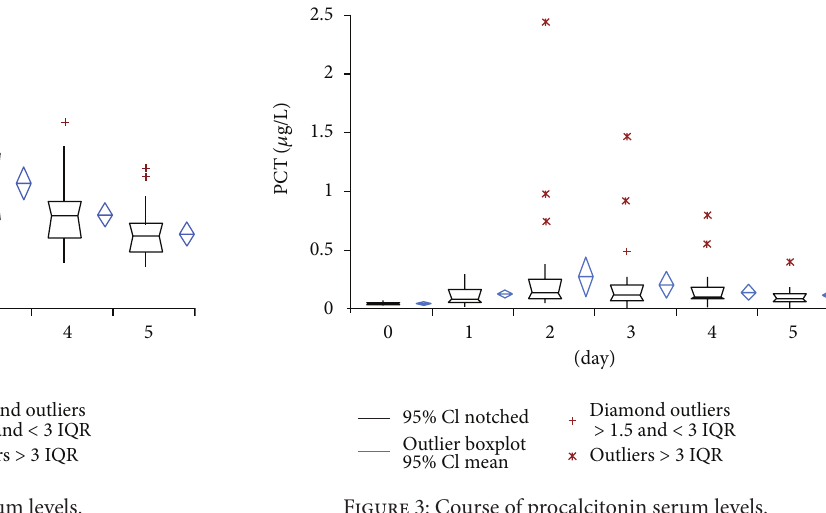
Figure 3: Course of procalcitonin serum levels.